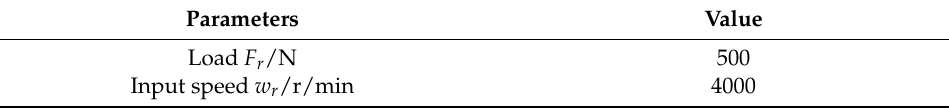
Table 2. Working conditions for the simulated bearing.